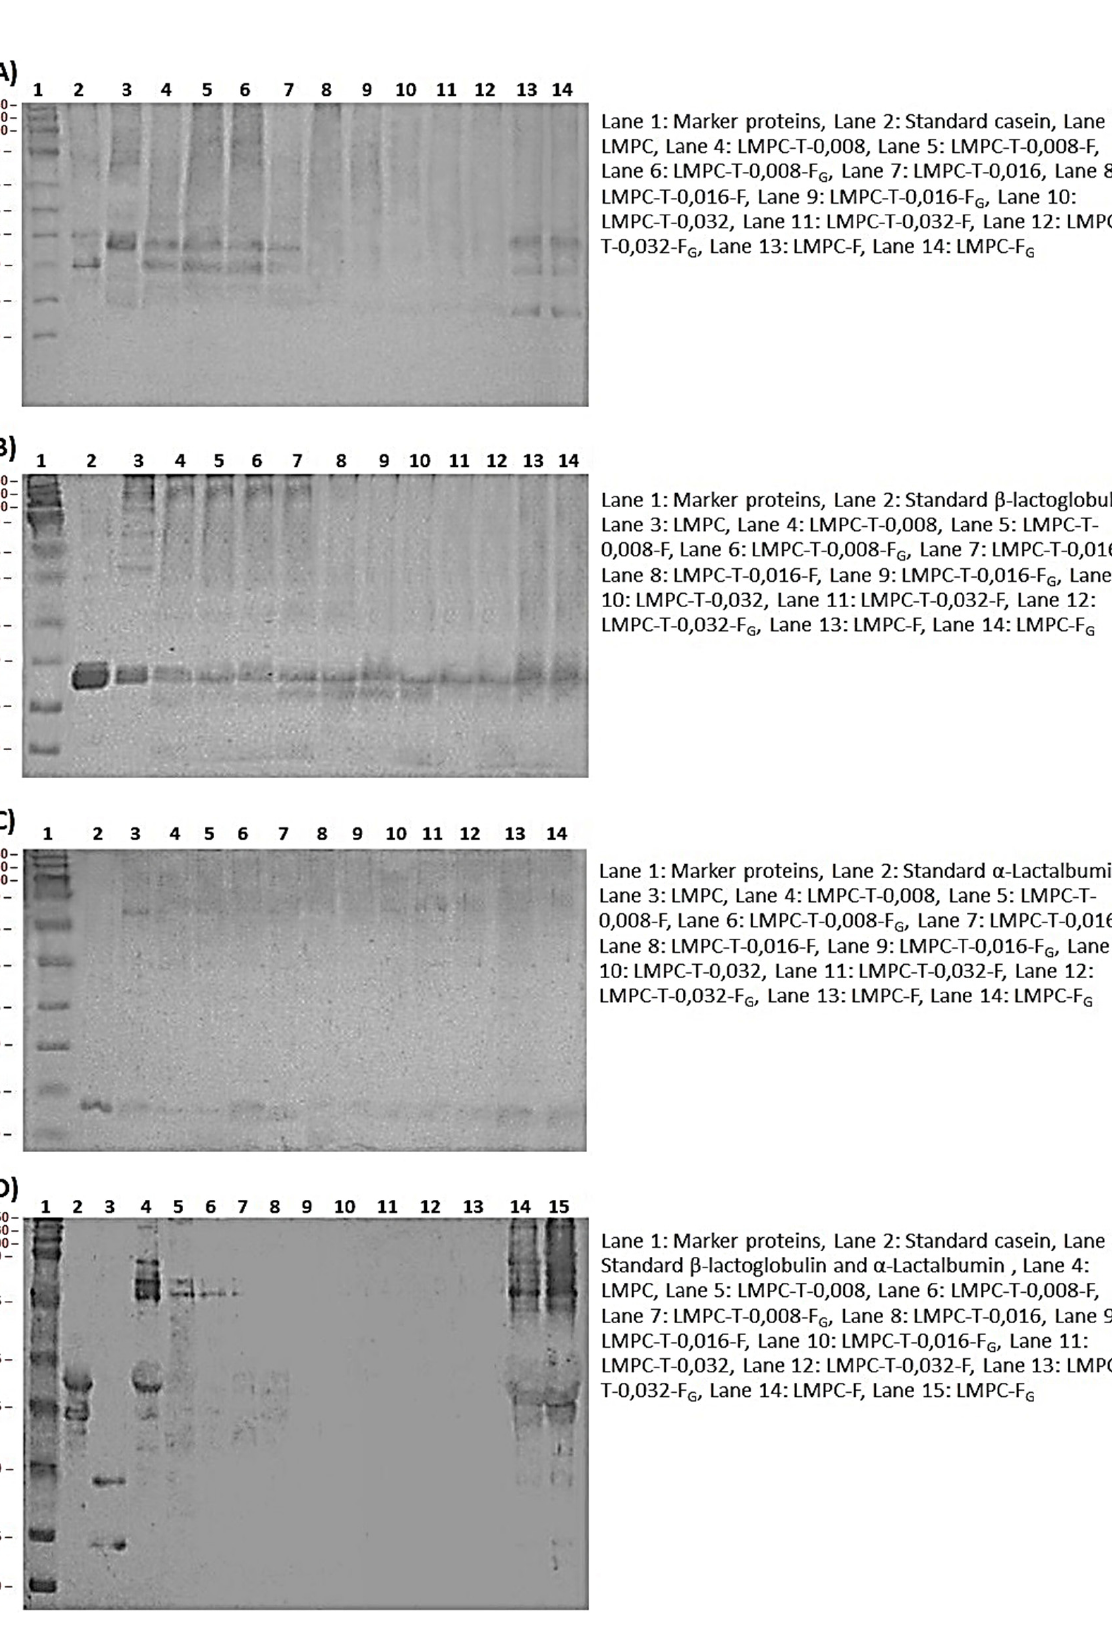
Figure 12. Immunogenicity in LMPC, LMPC-F, LMPC-F G , LMPC-T, LMPC-T-F and LMPC-T-F G . ( A ) Antigenicity against anti-casein Rb antibody, ( B ) antigenicity against anti- β -lactoglobulin Rb antibody, ( C ) antigenicity against anti- α -lactalbumin Rb antibody, and ( D ) allergenicity against cow’s milk allergenic human pooled serum.